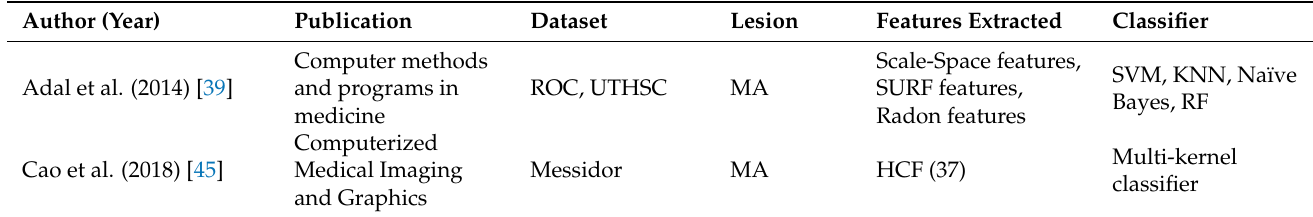
Table 8. Semi-supervised learning styles used in the